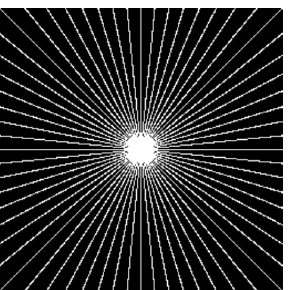
Figure 12. Sampling domain in the frequency plane, i.e., sampling operator S